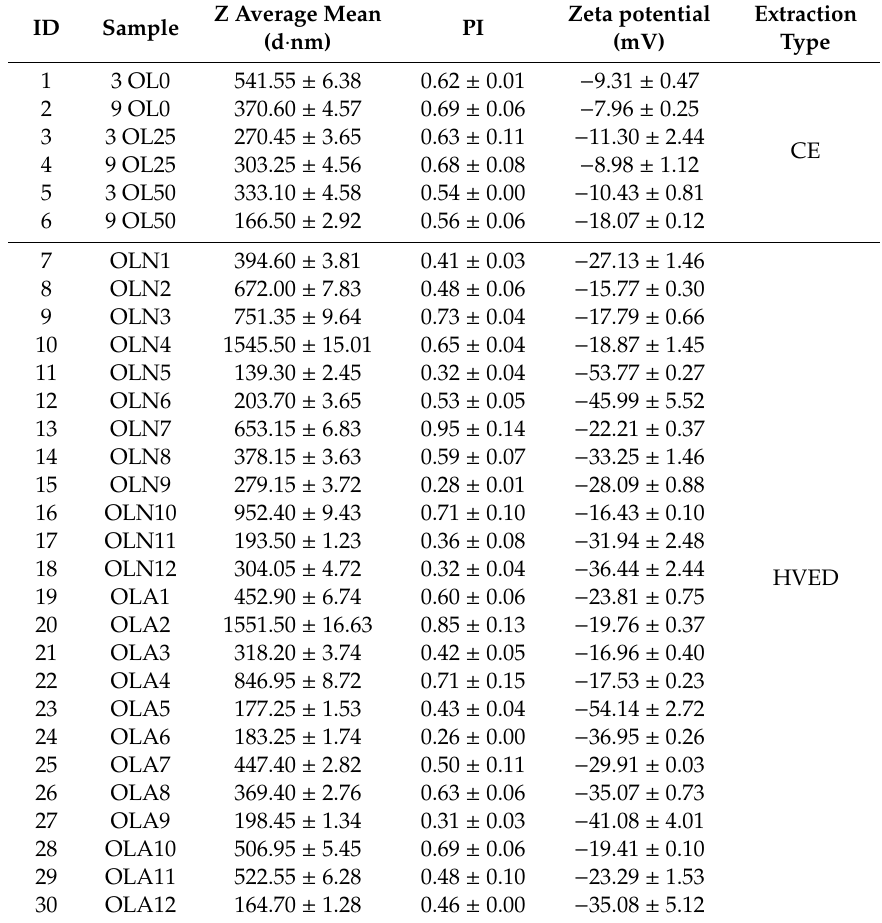
Table 6. Results of particle size and zeta potential analysis for CE and HVED treated